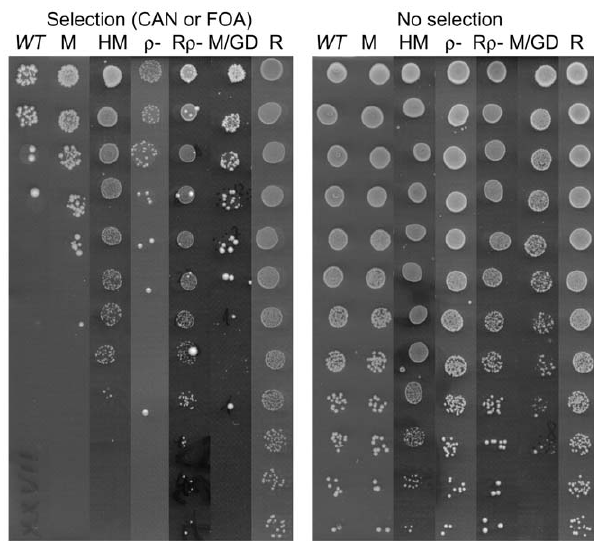
Figure 2. Example of results of the semi-quantitative SLM drop assay showing various categories of mutator phenotype. Cell suspensions were serially diluted and spotted onto selection plate (with canavanine or 5 9 -FOA) and onto dilution control plate as described in Materials and Methods. WT – SLM level in parental strain, M - increased SLM phenotype, HM - high SLM phenotype, r 2 - increased SLM due to respiratory incompetence in WT r 2 strain, R r 2 – resistance to selection conditions acquired along with the loss of respiratory competence, M/ GD - high SLM phenotype accompanied by decreased survival rate, seen also without selection, R - full resistance to selection